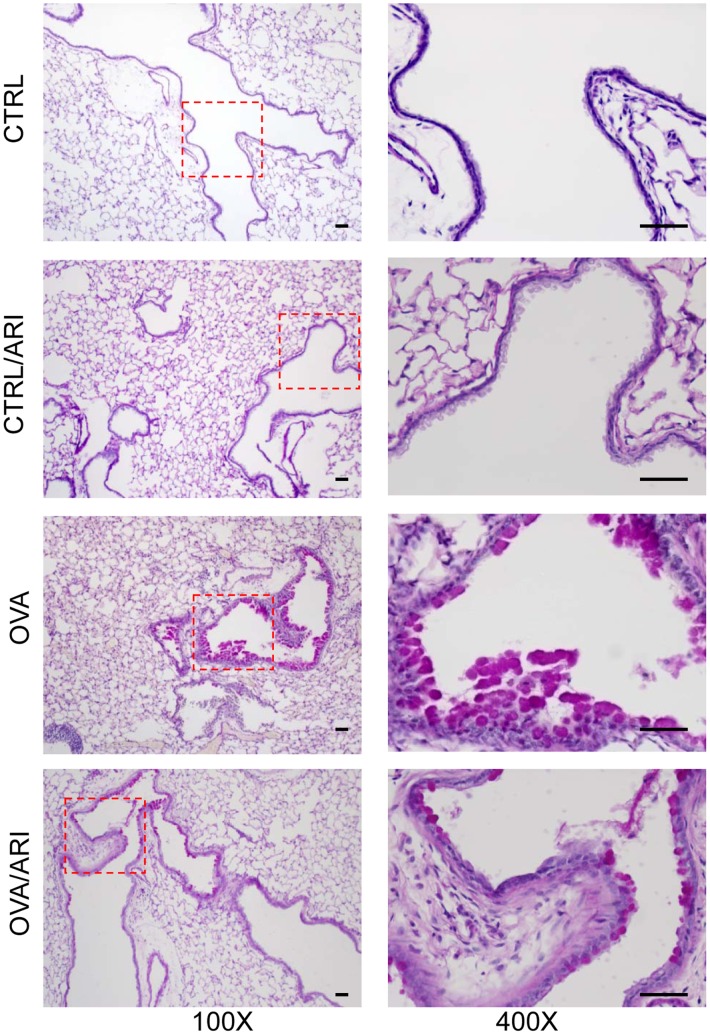
AR inhibition decreases OVA-induced metaplasia of mice lung epithelial cells.The lung sections of mice after 6-weeks of OVA-challenge were stained with PAS and observed under light microscope and photomicrographs were acquired. A representative photomicrograph is shown (n = 6). Magnifications 100× and 400×. CTRL, control, ARI, aldose reductase inhibitor, OVA, ovalbumin.